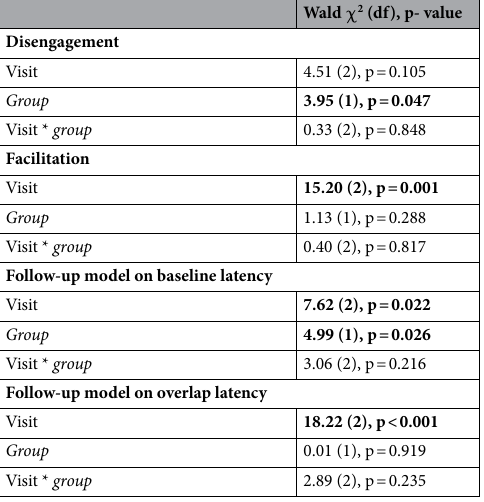
Table 1. Summary of GEE Model Effects including long-term user group (high and low users) and visit (12 months, 18 months, and 3.5 years) as predictors of the Gap-Overlap Task outcome measures. The analysis included 14 LUs and 26 HUs. Significant results are in